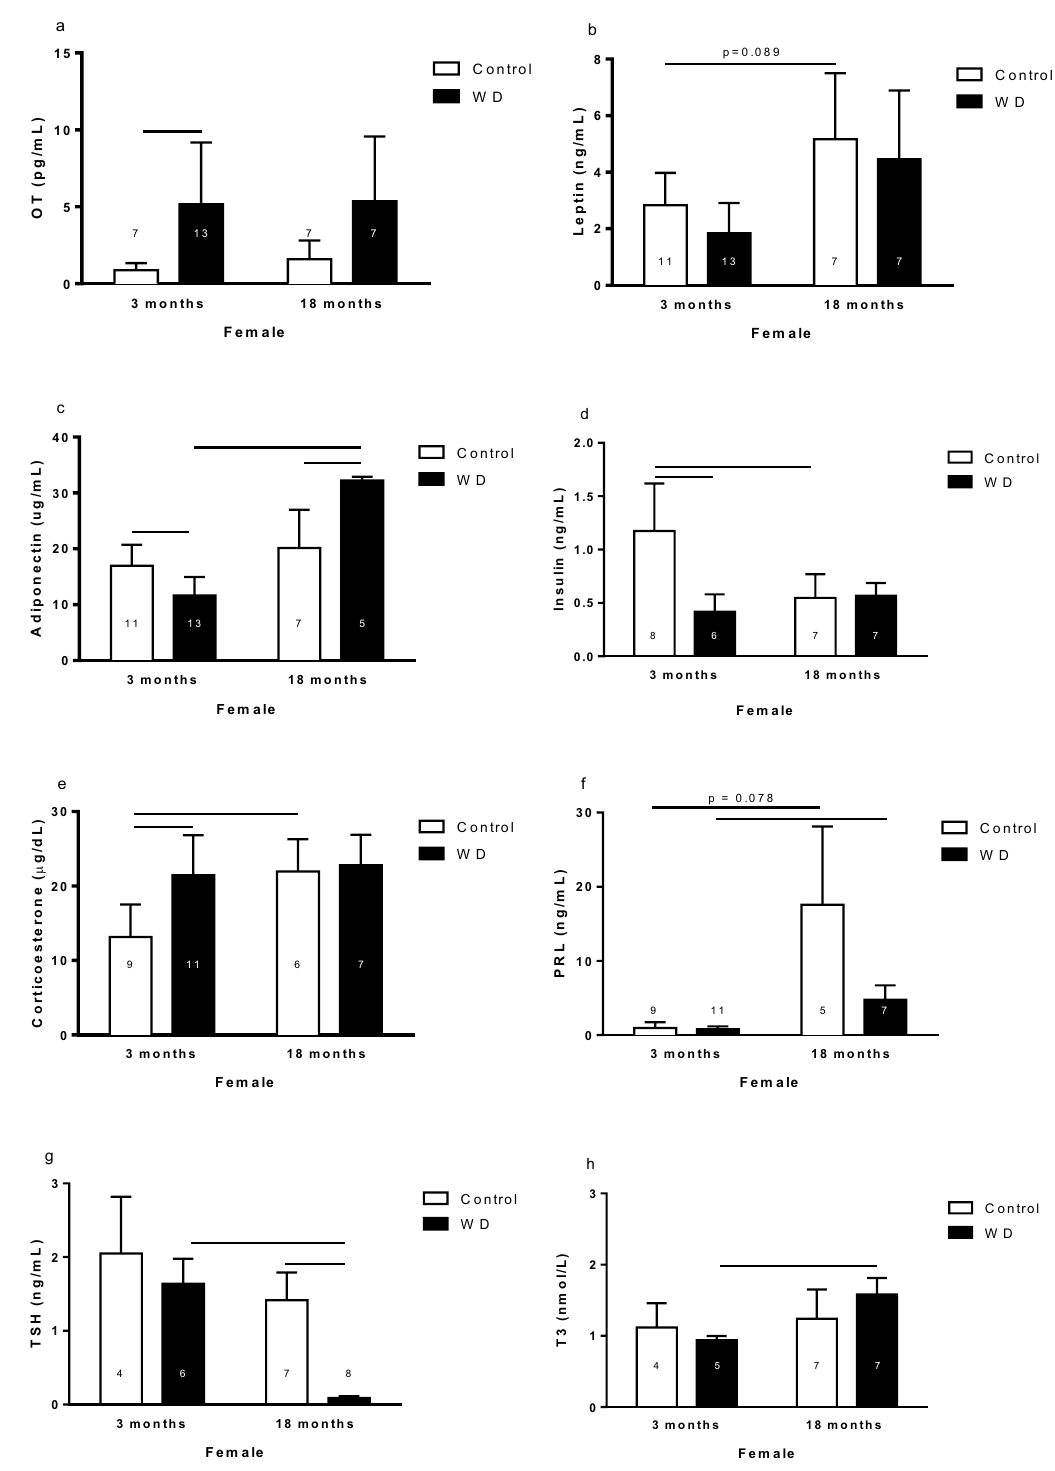
Figure 5. Oxytocin ( a ), leptin ( b ), adiponectin ( c ), insulin ( d ), corticosterone ( e ), prolactin ( f ), thyroid stimulating hormone (TSH) ( g ), and triiodothyronine ( h ) plasma concentration of 3- and 18-month-old female control and rats with water deprivation (WD). Data are presented as means (SD), p < 0.05 among the indicated groups. Two-way ANOVA followed by Newman-Keuls post-test when variances were equal, and Games-Howell when variances were different. The n for each group is inside or above the